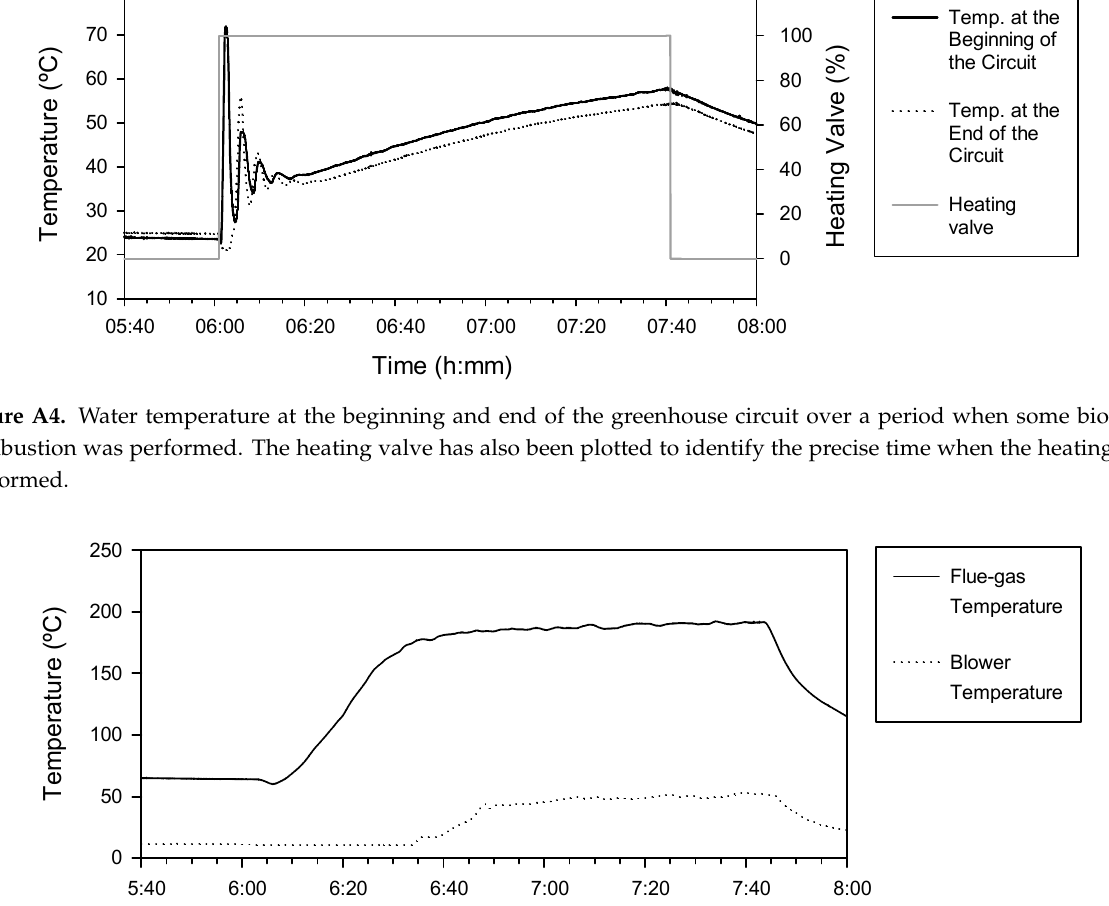
Figure A3. Diagram of the water circuit used for heating.